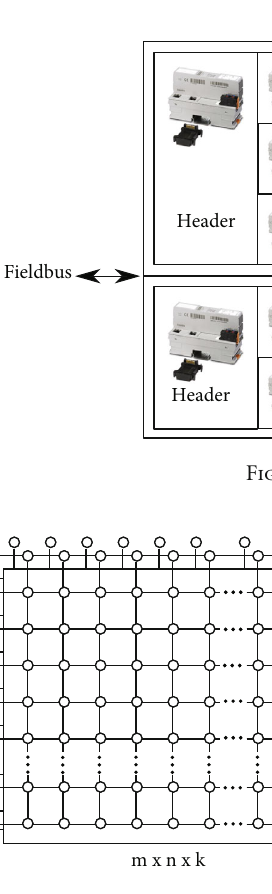
Figure 17: Internal structure of a connection